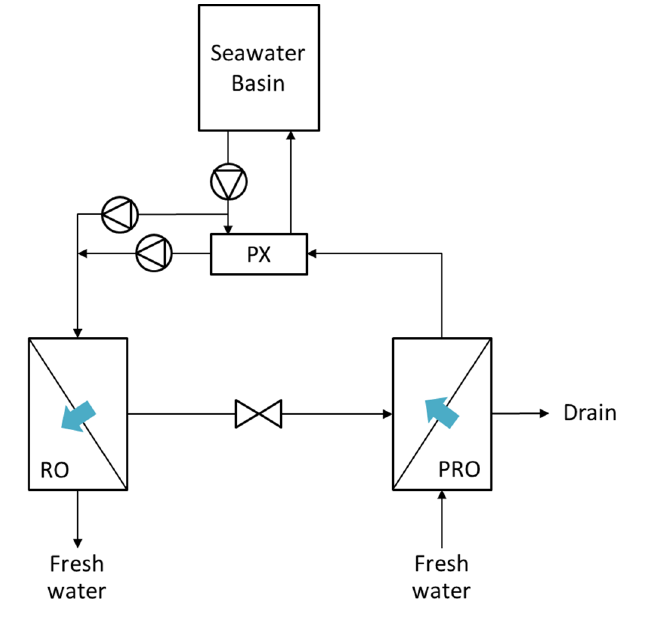
Figure 7. Schematic of the RO-PRO hybrid system in the US, adapted from [48].